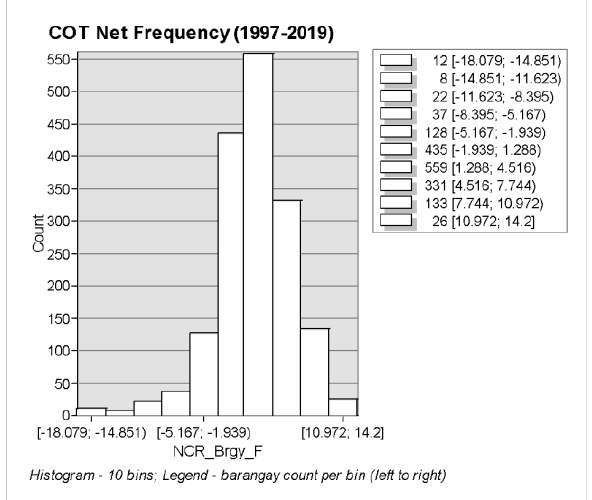
Figure 4. Histogram (10 bins) of output net frequency of cluster and outlier types (COT) in Metro Manila for 1997 to 2019.